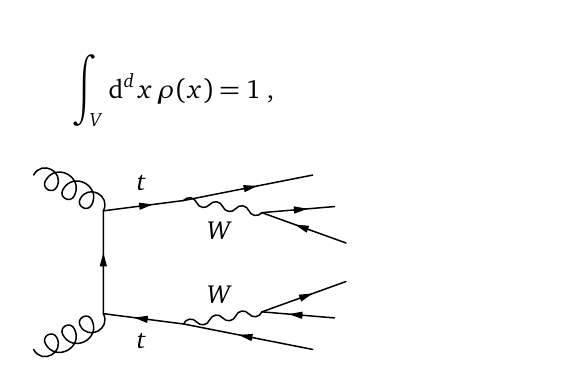
Figure 1: Sample Feynman diagram contributing to top pair production, with inter- mediate on-shell particles